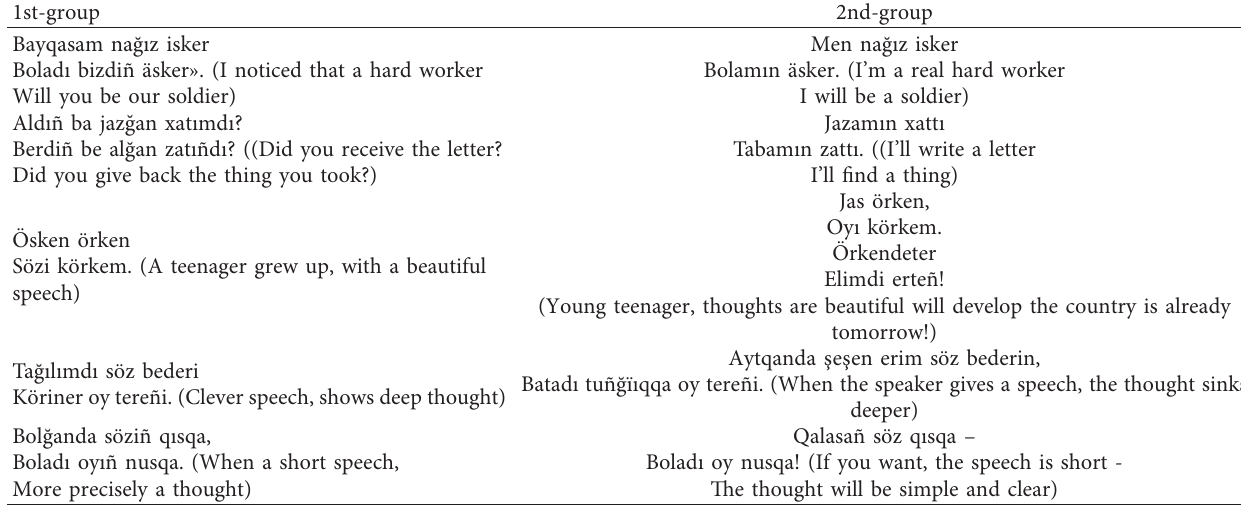
Table 3: Structure of the